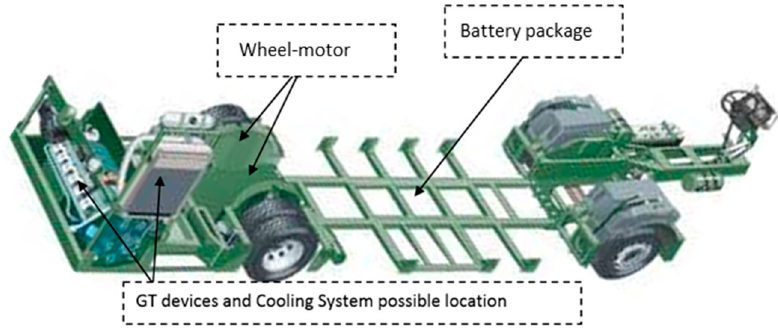
Figure 15. Example of Components Packaging and Weight Distribution for a Passenger Sedan.